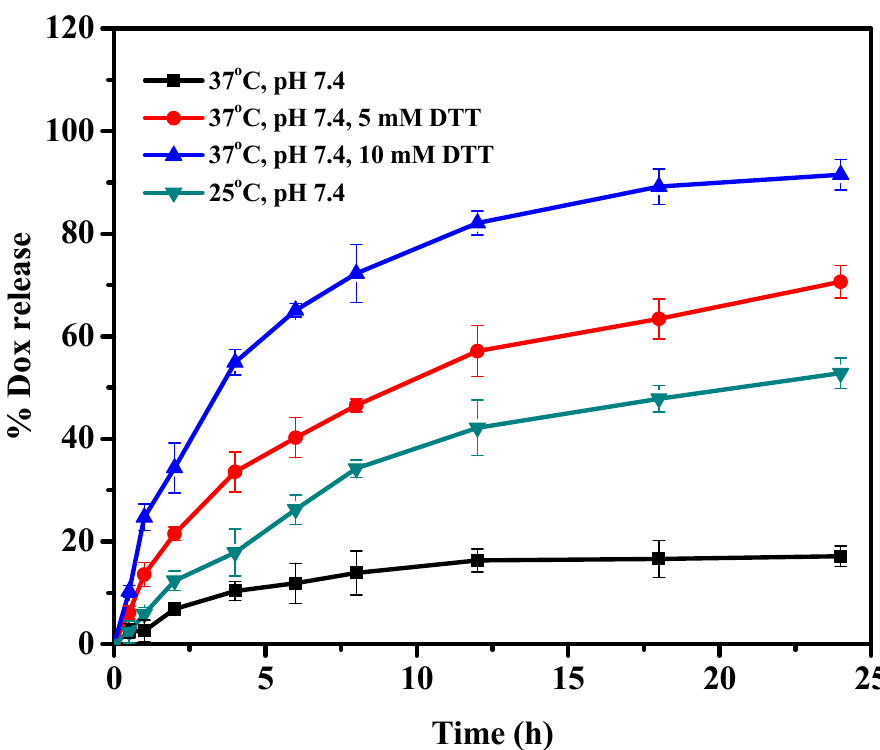
Figure 4. In vitro Dox release from Cys-BIS-P(VCL-HEA) nanogels in response to external stimuli (temperature) and internal stimuli (DTT).